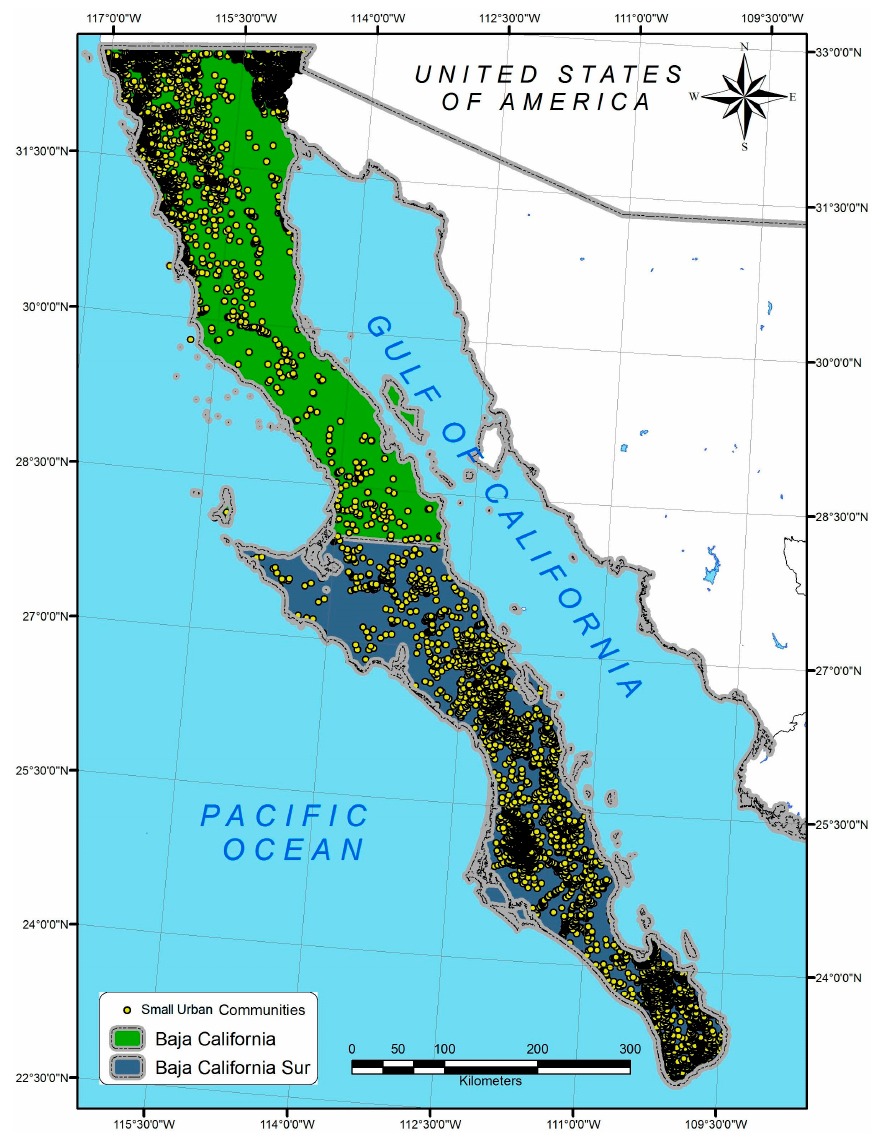
Figure 3. Distribution of small urban communities on the Baja California Peninsula, Mexico.